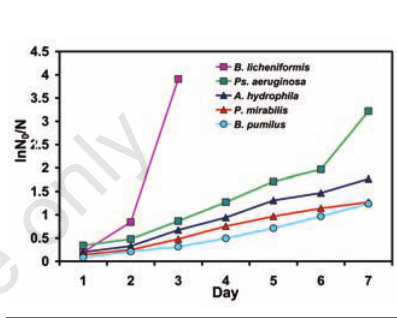
Figure 2. Comparative study of ln (N0/N) with time in days for the five bacterial iso- lates, where N is the initial concentration 0 of dimethoate and N is the dimethoate left at the end of 24 h incubation period.